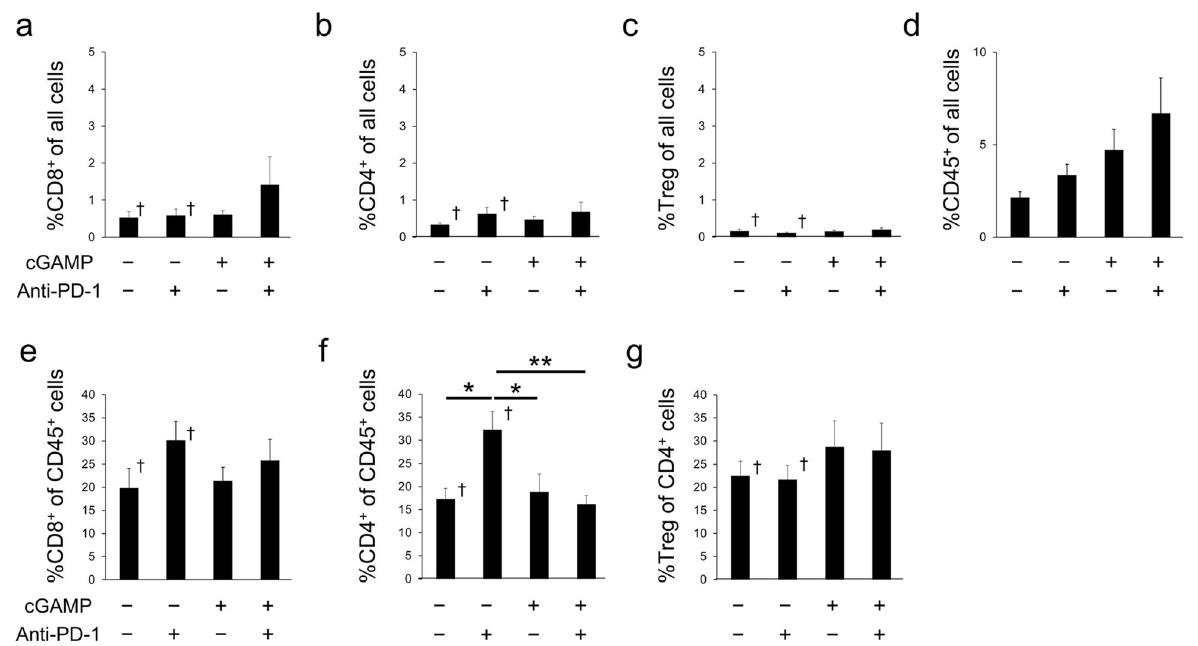
Fig. 3 Flow-cytometry analysis of immune cell populations in tumors from the cGAMP-injected B16F10 model. Percentage of CD8 + cells ( a ), CD4 + cells ( b ), Foxp3 + cells (Treg, c ), and CD45 + cells ( d ) in all cells in tumors on day 7 ( n = 5 – 7). Percentage of CD8 + cells ( e ) and CD4 + cells ( f ) in CD45 + cells in tumors on day 7 ( n = 5 – 7). Percentage of Foxp3 + cells (Treg, g ) of CD4 + cells in tumors on day 7 ( n = 5 – 7). Data of the non- treatment group and anti-PD-1-treated group were quoted from [11]. Data represent the mean ± SEM; * p < 0.05; ** p < 0.01; † Adapted from